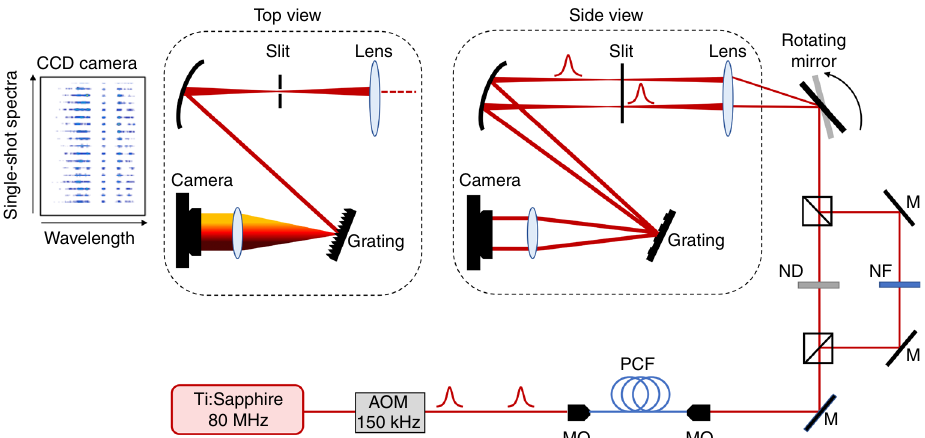
Fig. 5 Experimental setup. Ti:Sapphire Titanium-Sapphire mode-locked laser, AOM acousto-optic modulator, MO microscope objective, PCF photonic crystal fi bre, M mirror, ND neutral density fi lter, NF notch fi lter, CCD charge coupled device. Side views and top views of the grating imaging setup are shown